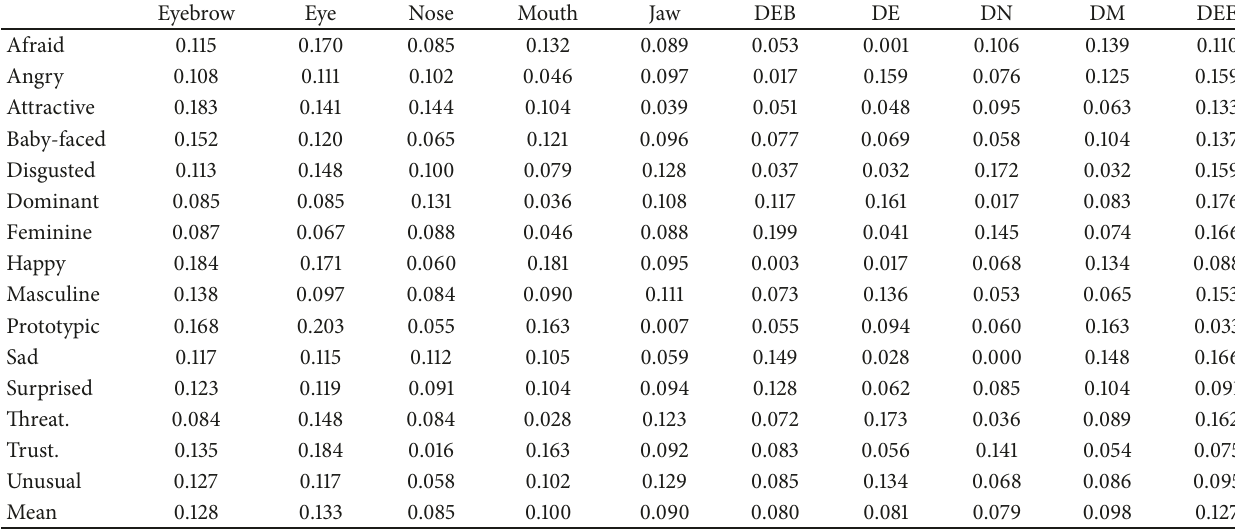
Figure 6: Process to obtain the predicted score of the allele M5. Table 1: Weight of each feature on social traits appraisals normalized to sum up 1 for each